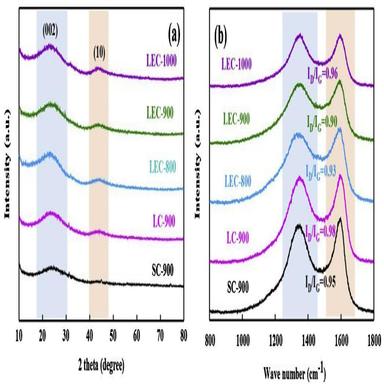
(a) XRD patterns and (b) Raman spectra obtained from the SC-900, LC-900, LEC-800, LEC-900 and LEC-1000 samples.